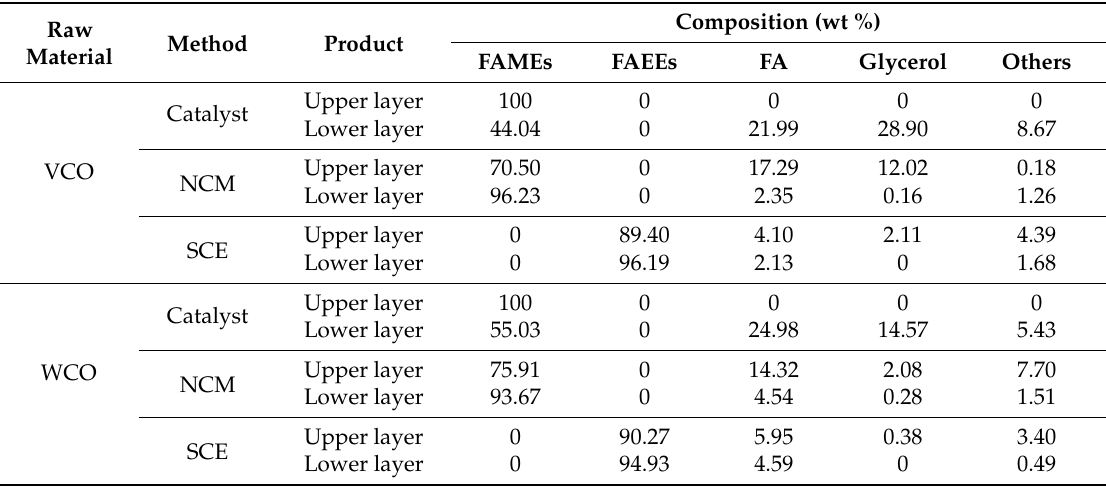
Table 4. Compositions of product obtained from catalyzed and supercritical fluid method. Raw Material